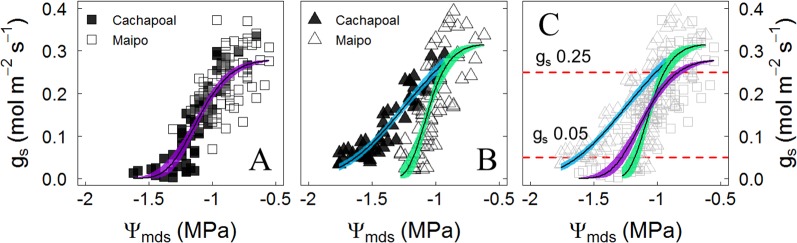
Stomatal conductance (gs) response to Ψmds in (A) Carménère, (B) Syrah, and (C) all plants during drought progression in the field in the Cachapoal (Cachapoal valley) and Maipo (2018) valleys in Chile. Red and Purple squares correspond to Carménère in 2017 and 2018, respectively, and light blue and green triangles are Syrah in 2017 and 2018, respectively. Solid line shows the non-linear regression, and the colored area is the 95% confidence interval for the mean. Upper and lower segmented red lines in C indicate gs value at 0.25 mol m-2 s-1 and 0.05 mol m-2 s-1.